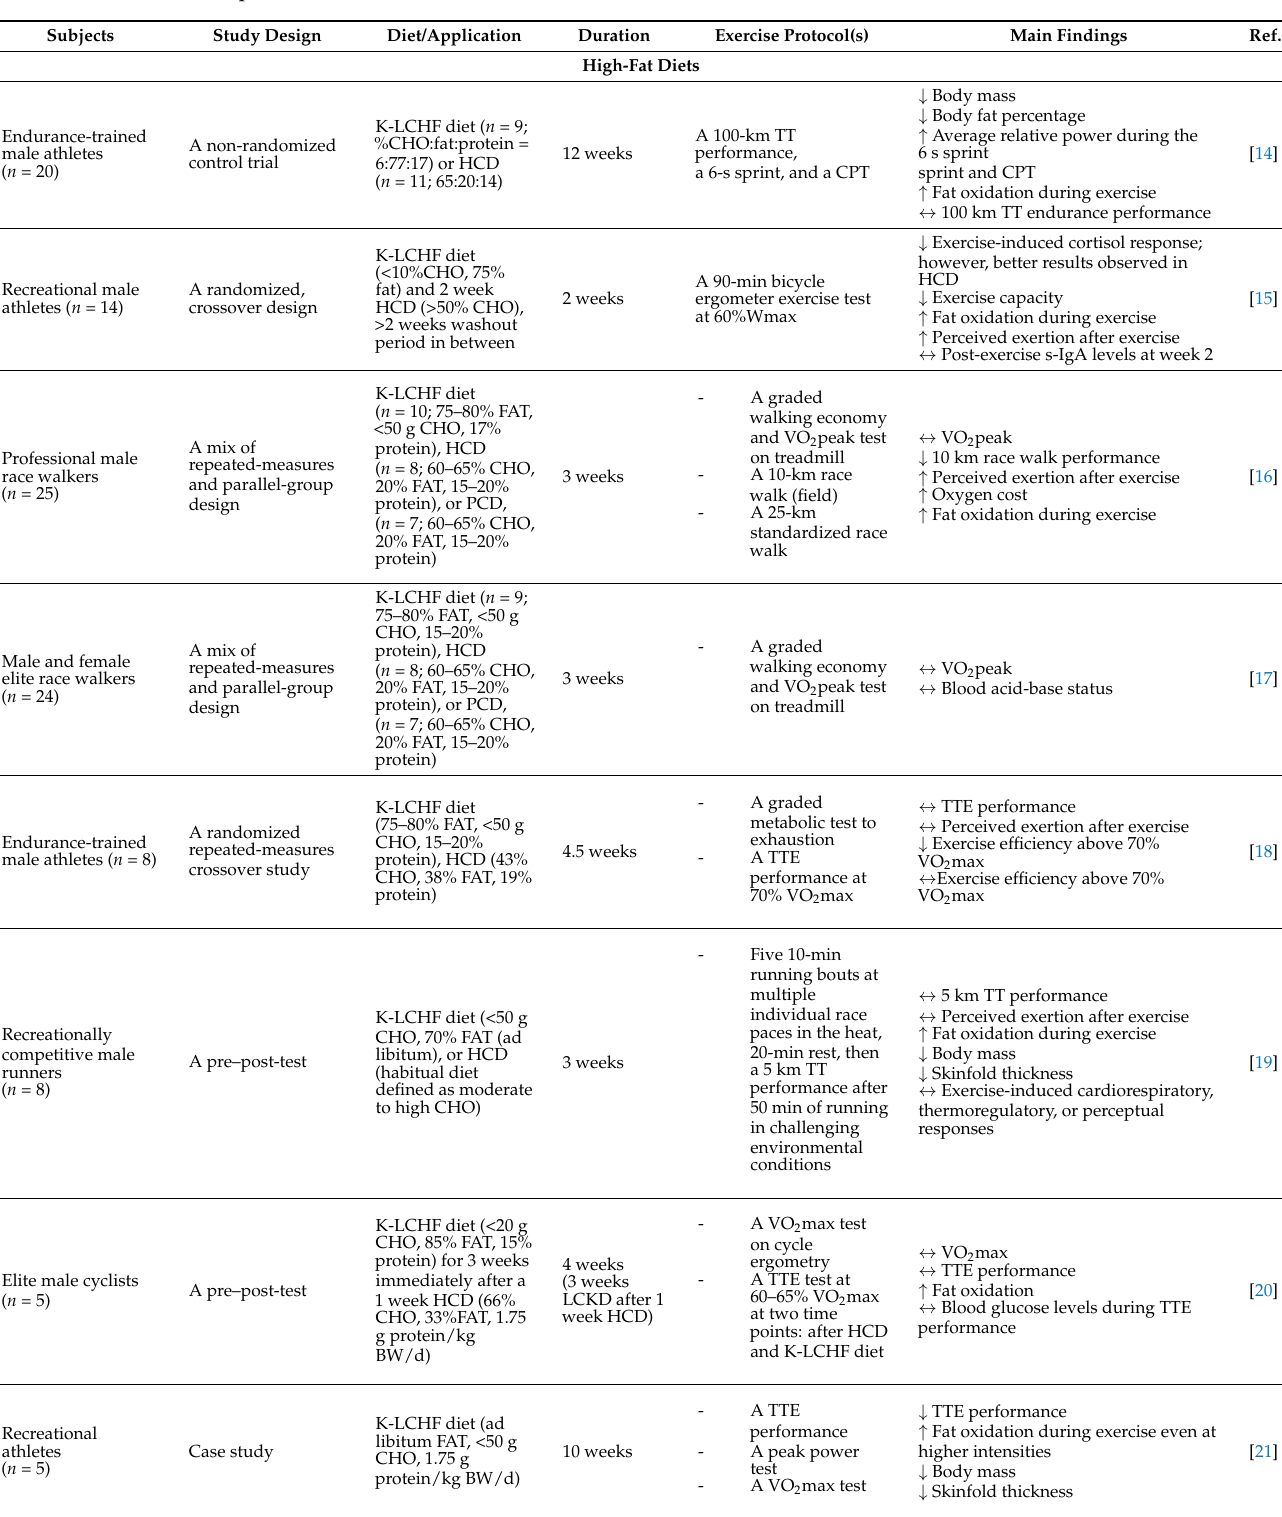
Table 1. Studies investigating the potential effects of vegetarian, fasting, high-fat, gluten-free, and low-FODMAP diets on athletes’ endurance